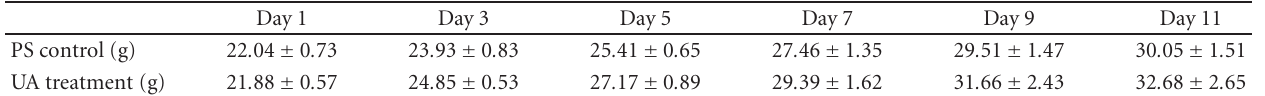
Figure 2: UA inhibited proliferation and induced apoptosis in hepatocellular carcinoma cell H22 mouse xenograft. (a) Xenografts treated with PS or UA were imaged by PET-CT. (b) Cell cycle of tumor cells from xenografts treated with PS or UA was examined. Cell cycle distribution was showed in the table ( ∗ P < . 05). (c) Apoptosis of tumor cells from xenografts induced by UA was detected by Annexin-V staining and flow cytometry. Quantified data showed in the table below ( ∗ P < . 05). (d) Western blot showed expression of Caspase-3 and Caspase-8 in tumor cells from xenografts treated with PS or UA. Table 2: Weight of xenografts treated with PS or